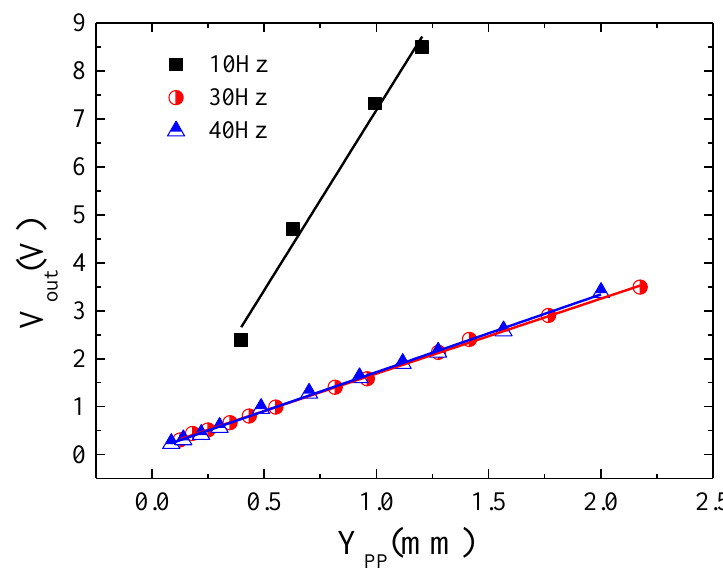
Figure 9. Sensor output signal V out , versus amplitude, Y pp , of vibration of the energy harvester (sensor at rest with respect to the vibrating platform).